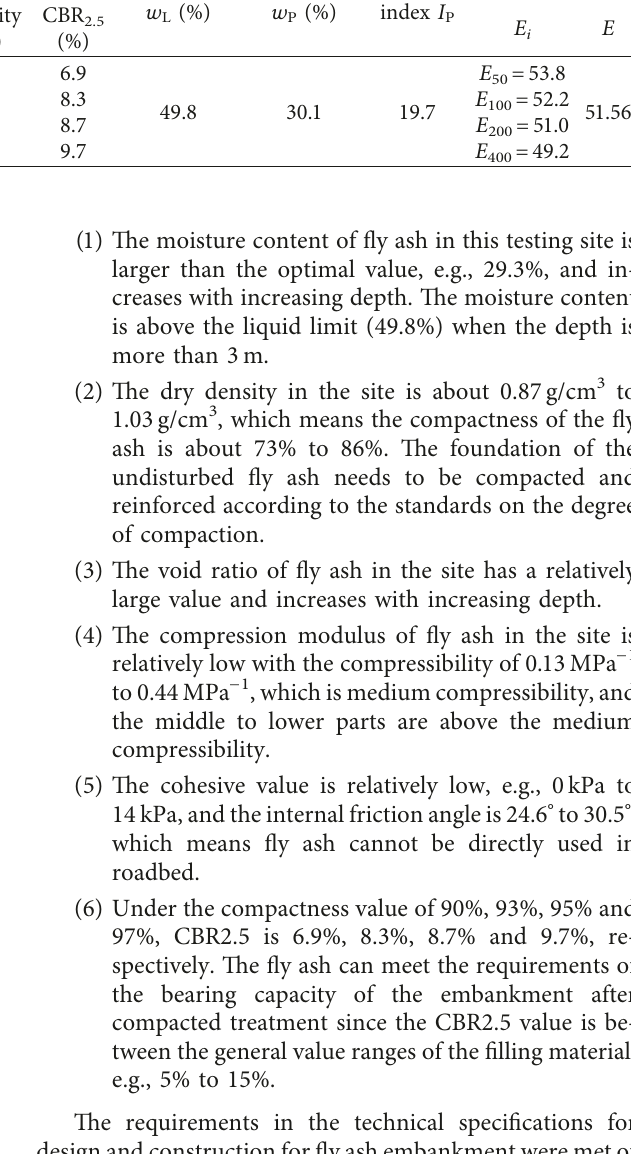
Figure 3: Stress-rebound deformation curve of fly ash at maximum dry density.